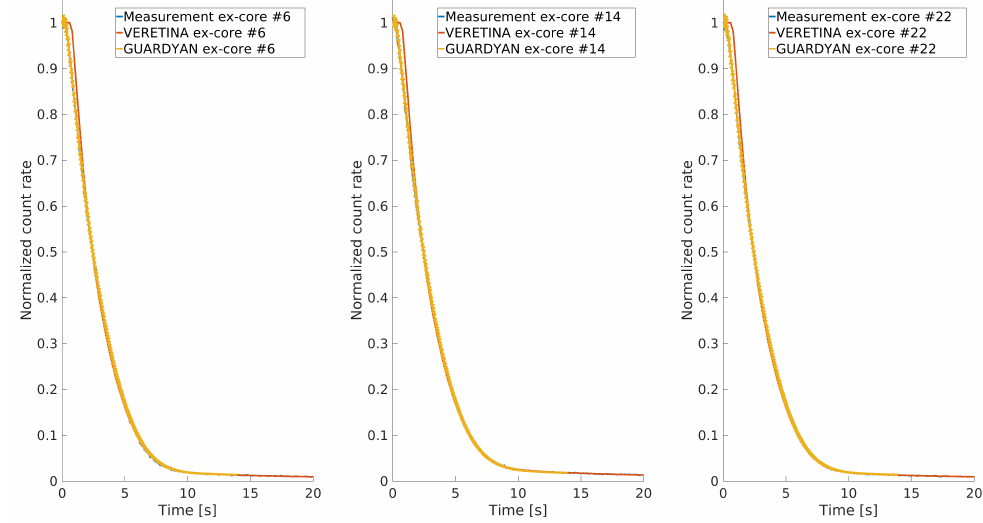
Figure 9. Comparison of ex-core detector signals to GUARDYAN and VERETINA results, linear